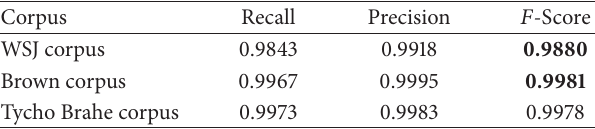
Table 8: Classification results of i Sentenizer- 𝜇